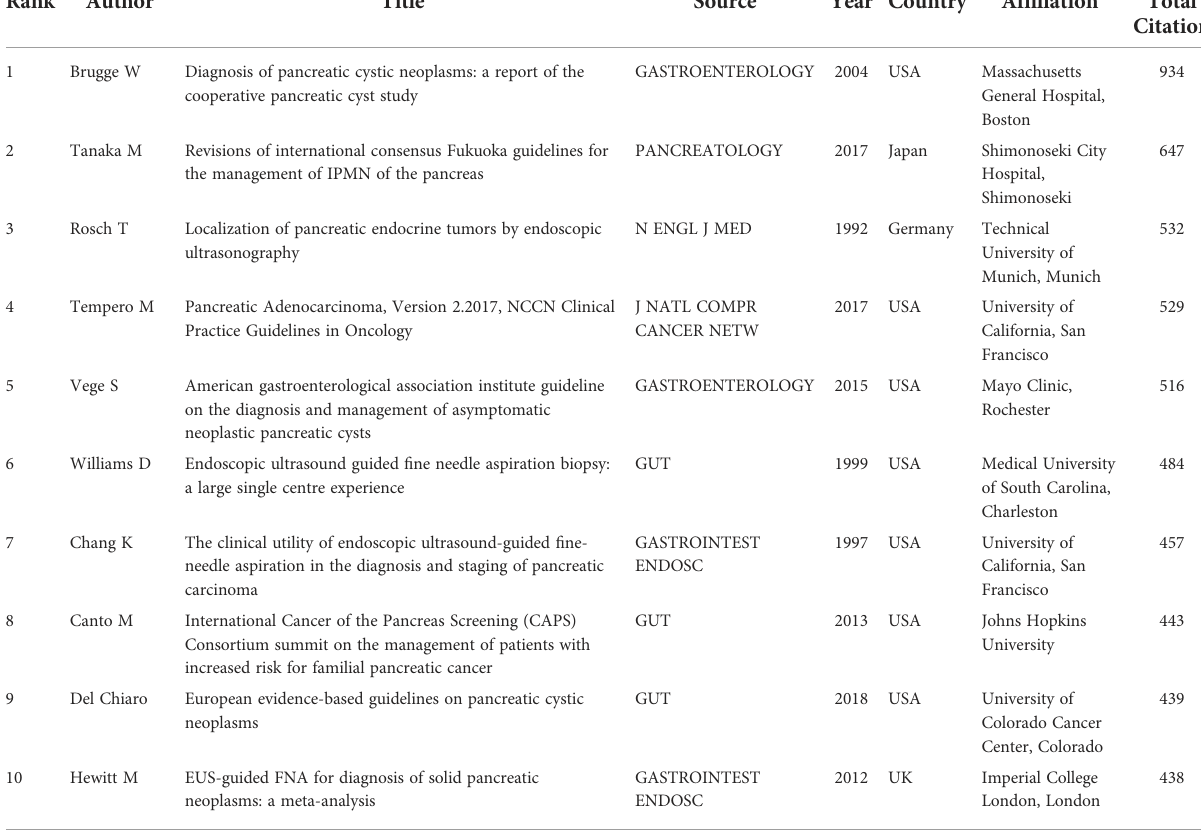
TABLE 1 Top 10 citation analysis of